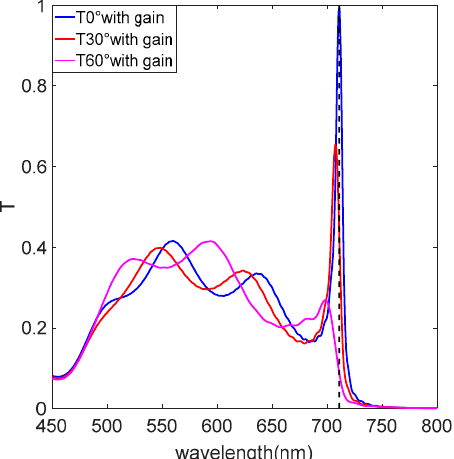
Figure 6. Transmittance characteristic with the gain medium.